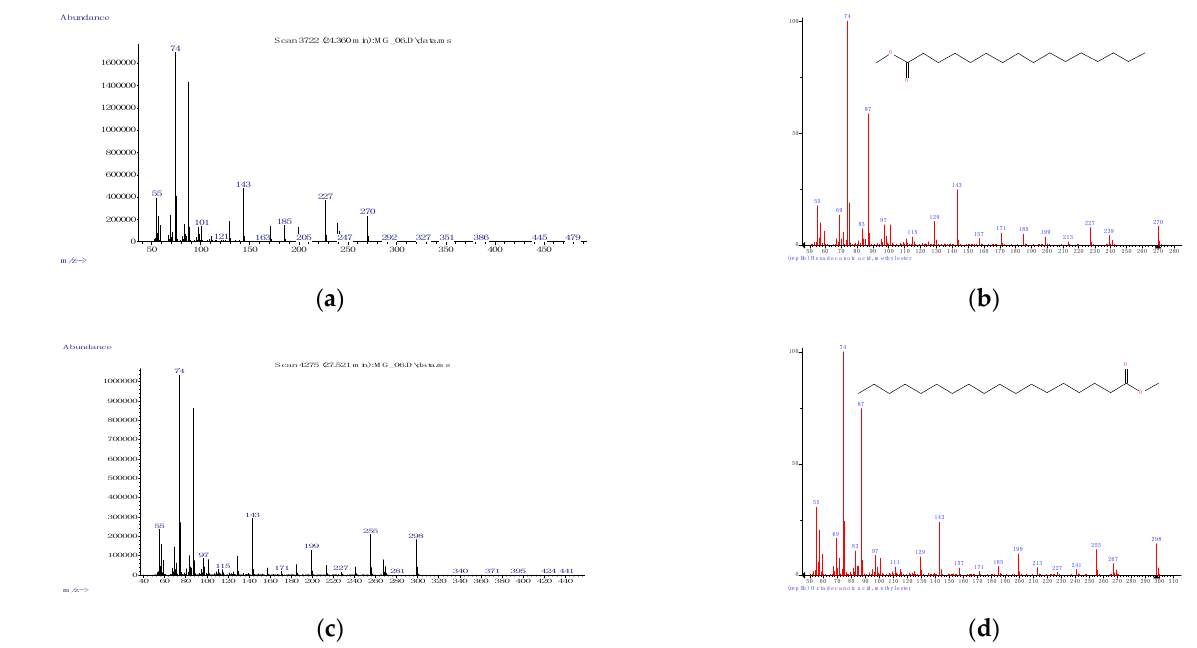
Figure 5. Experimental (left) and from the NIST 2011 database (right) mass spectra for the main fatty acids (as methyl esters) identified in the derivatized lipid fractions from Mangalitza hard fat—Saturated fatty acids (SFAs): palmitic acid ( a , b ) and stearic acid ( c , d ).